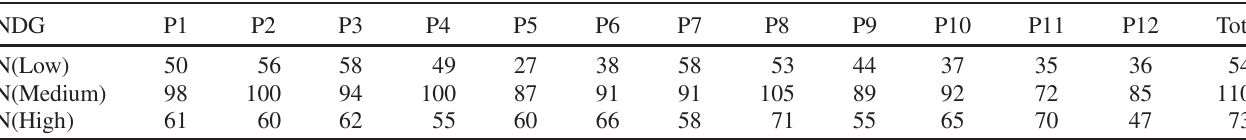
TABLE II. Number of IRT eligible students with different physics skills in the NDG condition. NDG